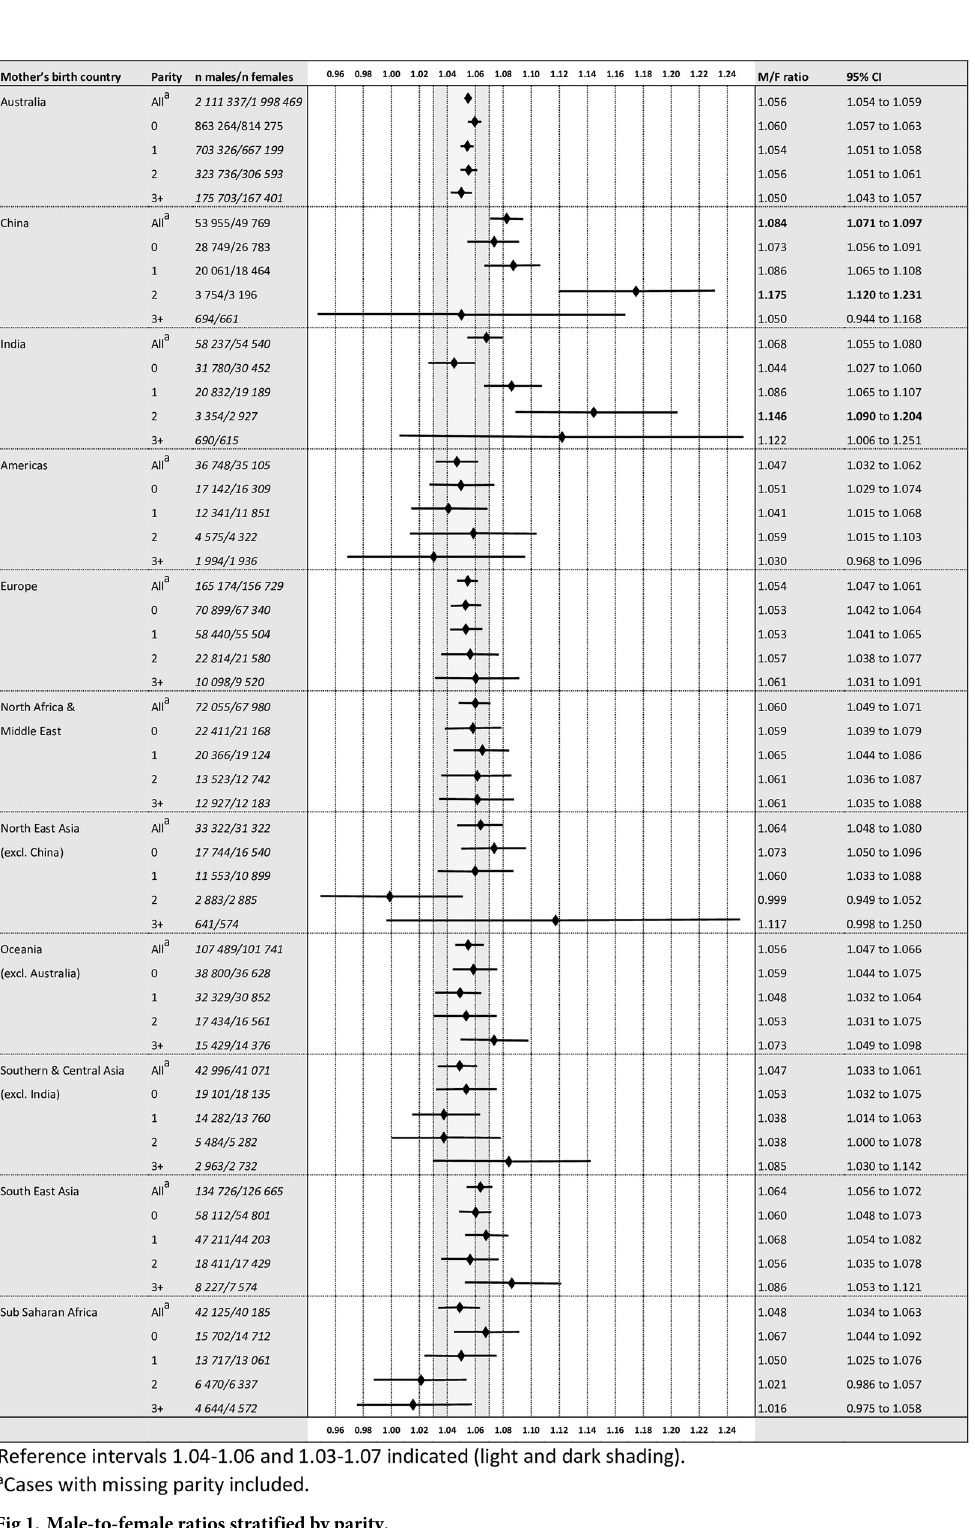
PLOS ONE | https://doi.org/10.1371/journal.pone.0251588 June 25,